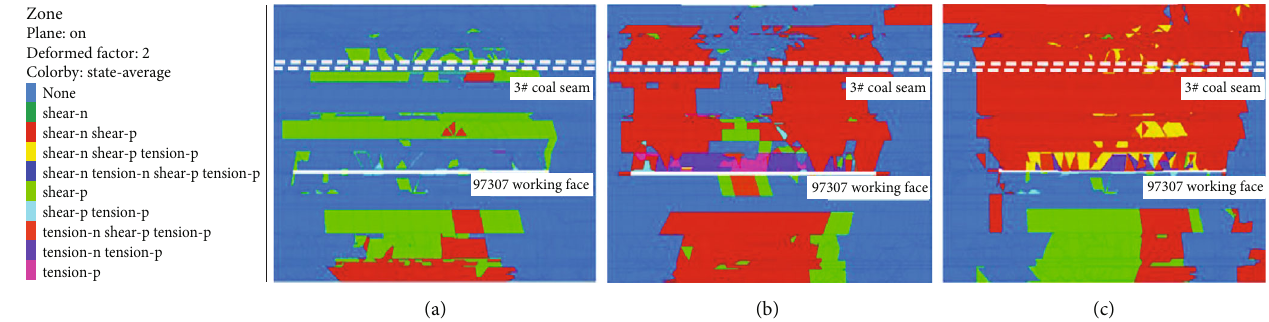
Figure 5: Cloud image of plastic zone in no. 3 coal seam during mining of 97307 working face. (a) Working face advancing 80m; (b) working face advancing 160m; (c) working face advancing 240m.